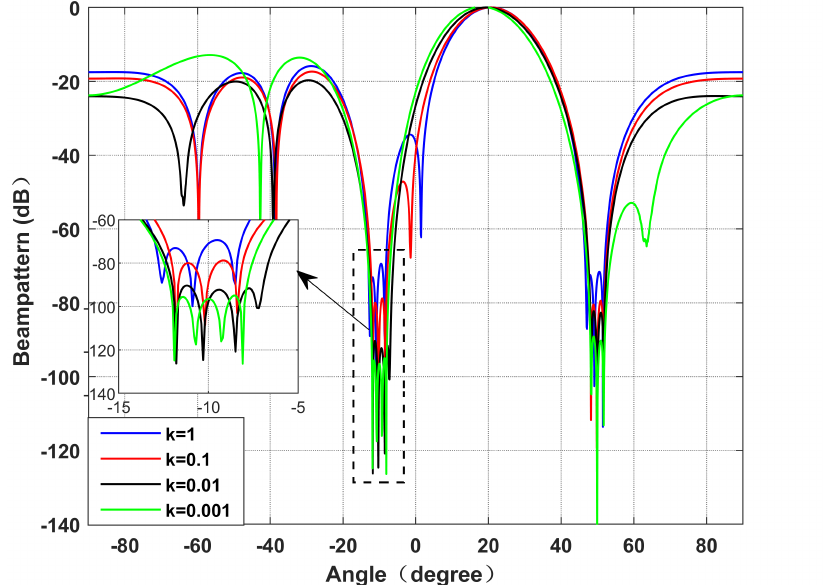
Figure 3. Beamforming diagram with different values of k . Simulation 1.